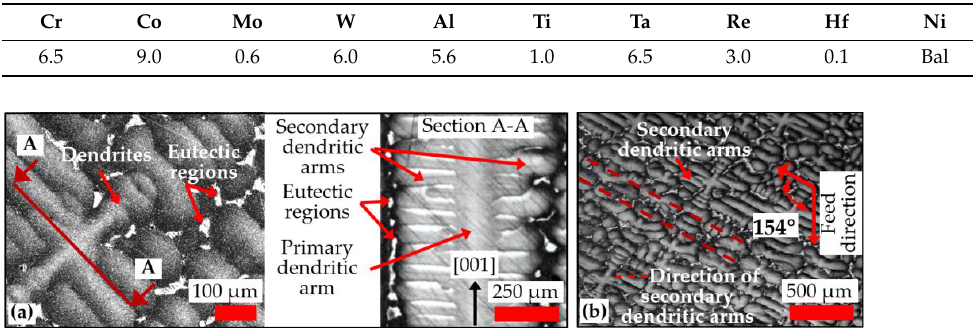
Figure 1. Metallographic microstructure of the CMSX-4 Ni-based superalloy highlighting ( a ) the orientation of dendritic growth and ( b ) the feed direction relative to the secondary dendritic arms.